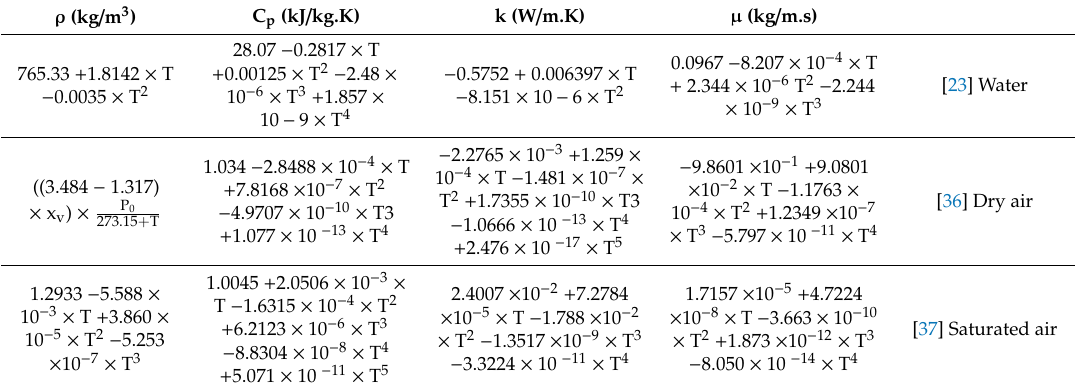
Table 3. Properties of water, dry air and saturated fluids.